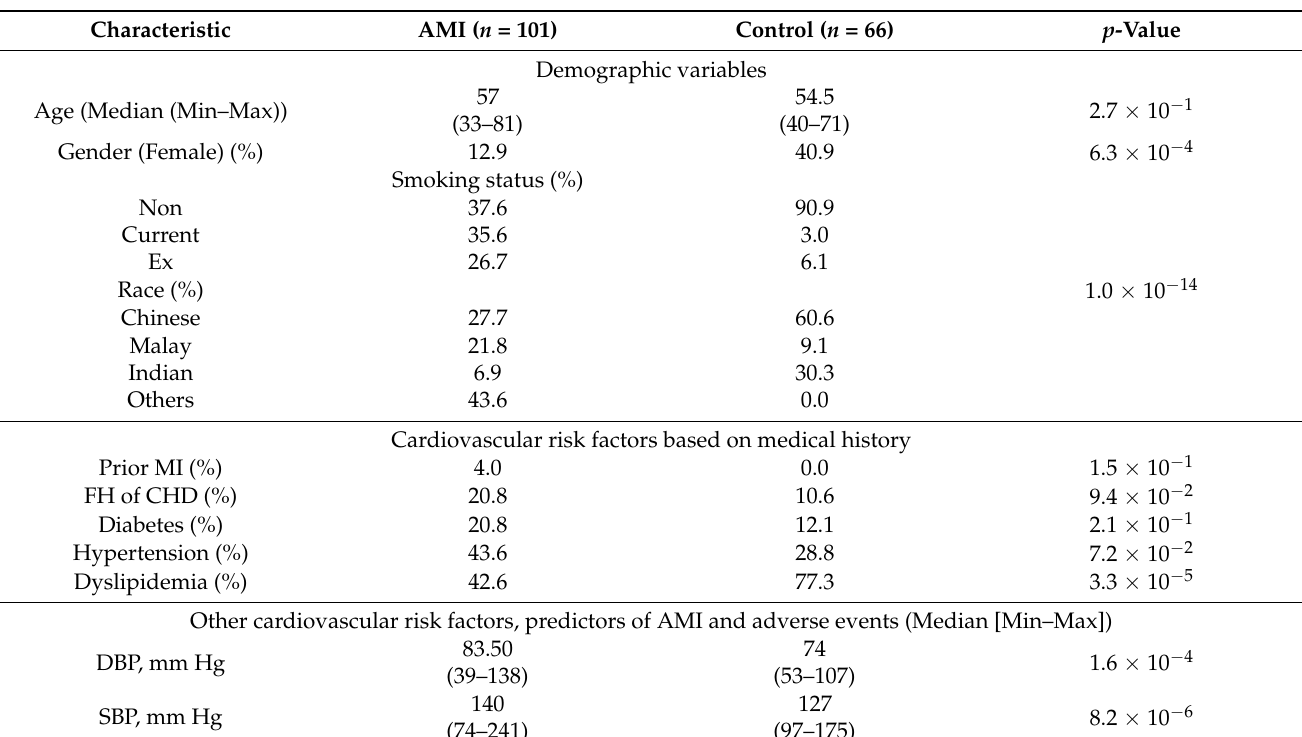
Table 1. Demographic characteristics of the study populations. Significant p -values are